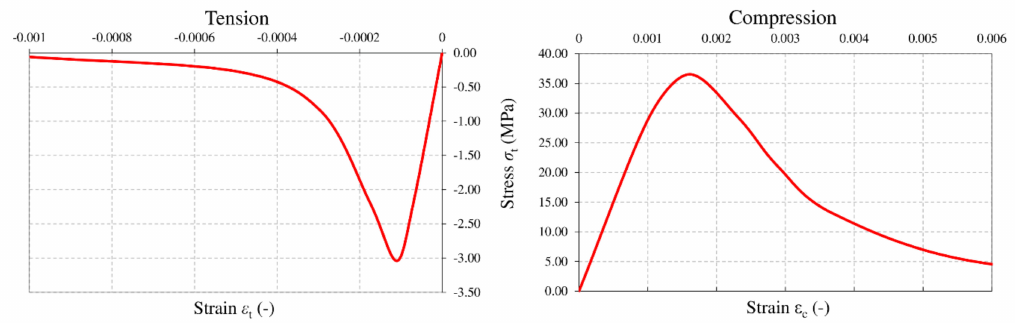
Figure 8. Physical laws of the concrete modelled in the numerical calculations.